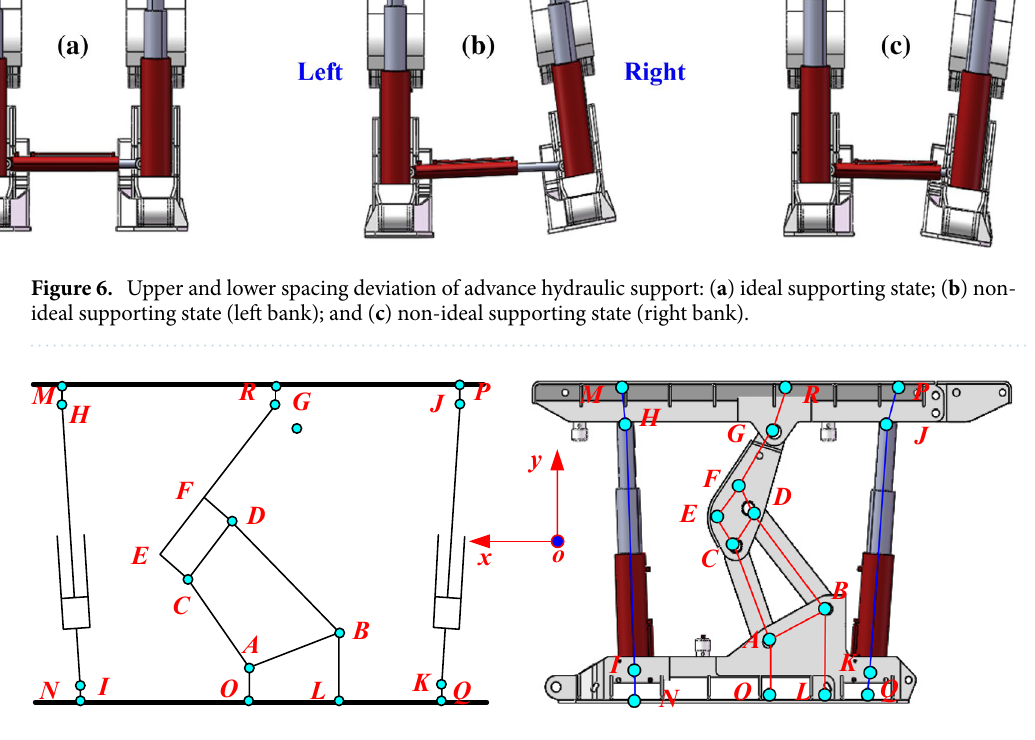
Figure 7. 2D model of the advance hydraulic